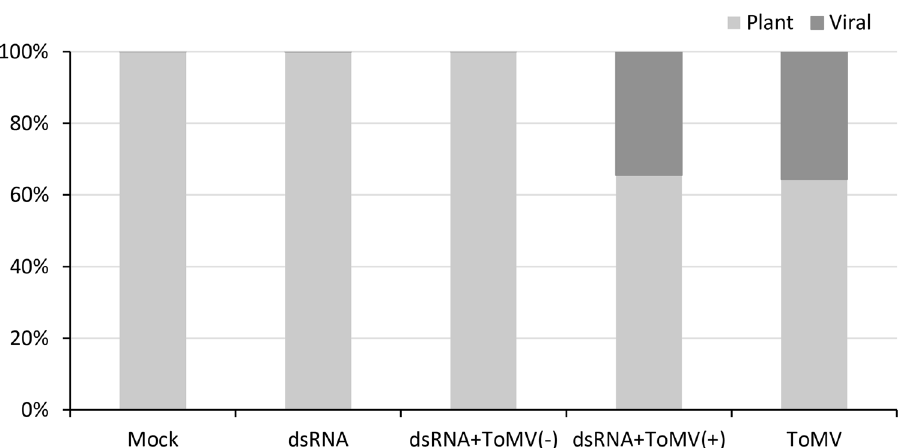
Figure 7. Rate of endogenous and viral small interfering RNA (siRNA) molecules in tomato plants. The siRNA libraries from five treatments [mock, dsRNA, dsRNA + ToMV(−), dsRNA + ToMV(+), and ToMV] were mapped to the tomato (assembly accession GCA_000188115) and tomato mosaic virus (accession FN985165) genome reference sequences. The results are expressed as average values of three repetitions (each composed of four plants) per